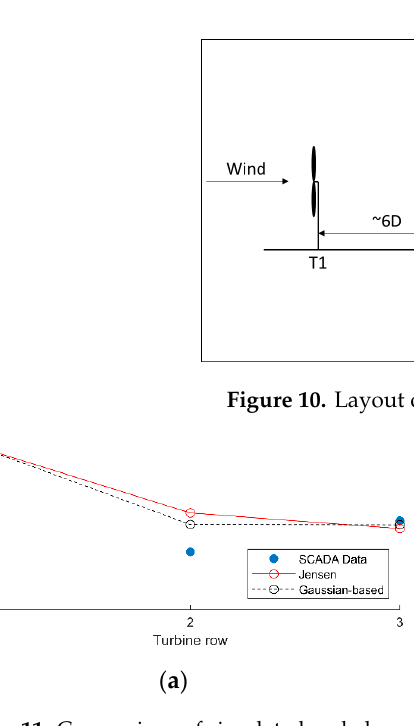
Figure 11. Comparison of simulated and observed power output under perfect alignment at the center of the wake with a wind direction of 158° ( a ) and partially waked condition with a wind direction of 155° ( b ).